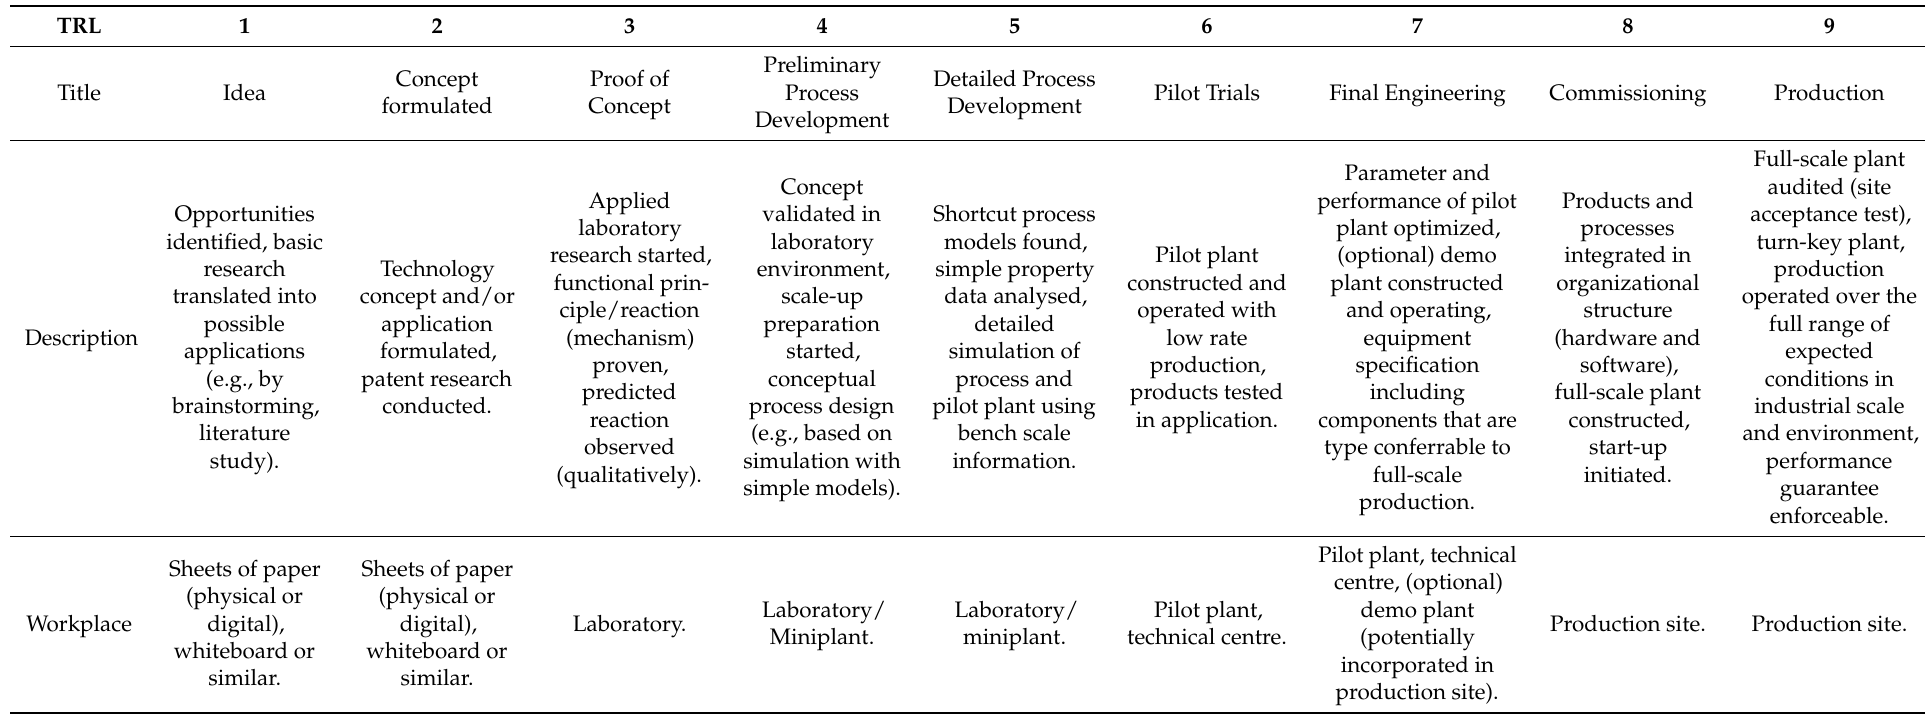
Table 1. Definition of Technology Readiness Levels (TRLs) for the Chemical industry. Adapted from